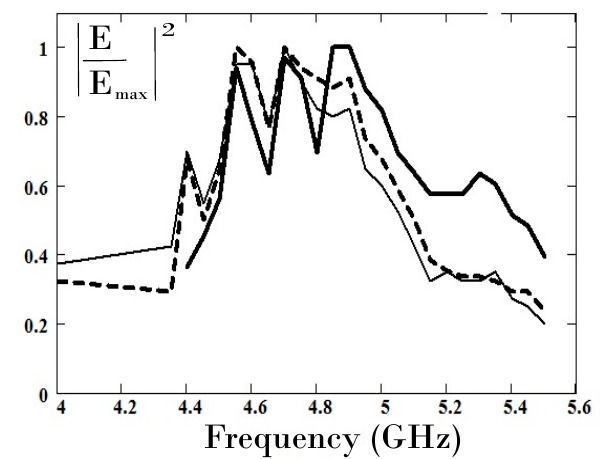
Figure 10. Square of the normalized field amplitude of the emitted signal as a function of frequency of C -range antennas made from fiber (dashed line), fabric (thin solid line), and metal (thick solid line). E max is the maximum value of the field